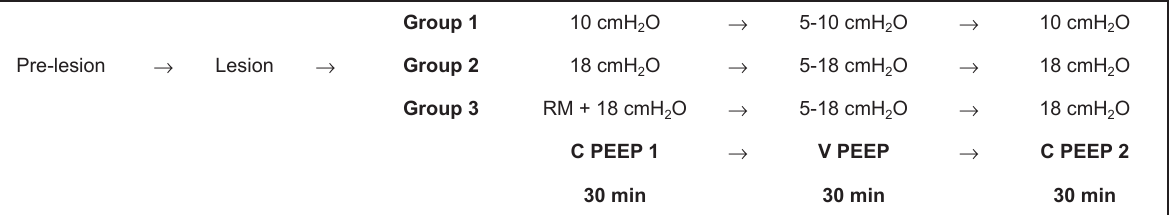
Figure 1. Protocol of the 5 experimental 30-min periods. PEEP = positive end-expiratory pressure; group 1 = low variable PEEP; group 2 = high variable PEEP; group 3 = alveolar recruitment maneuver (RM) + high variable PEEP; C PEEP 1 = constant PEEP period 1; V PEEP = variable PEEP; C PEEP 2 = constant PEEP period